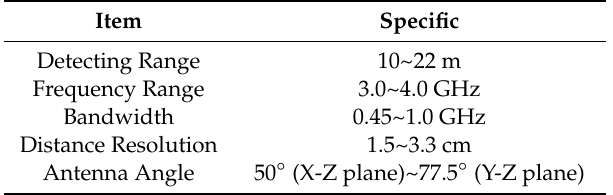
Table 6. UWB Radar Specification used for breathing signal data